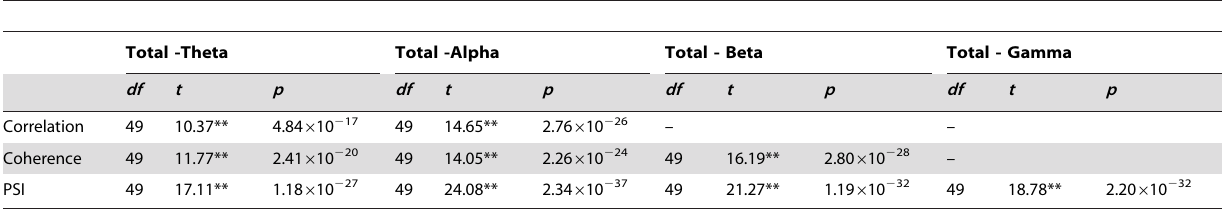
Table 8. Comparison of Classification Accuracy by Using Single Frequency Band Against Using Total Frequency Bands Base on Correlation, Coherence and Phase Synchronization Index with Feature Selection.